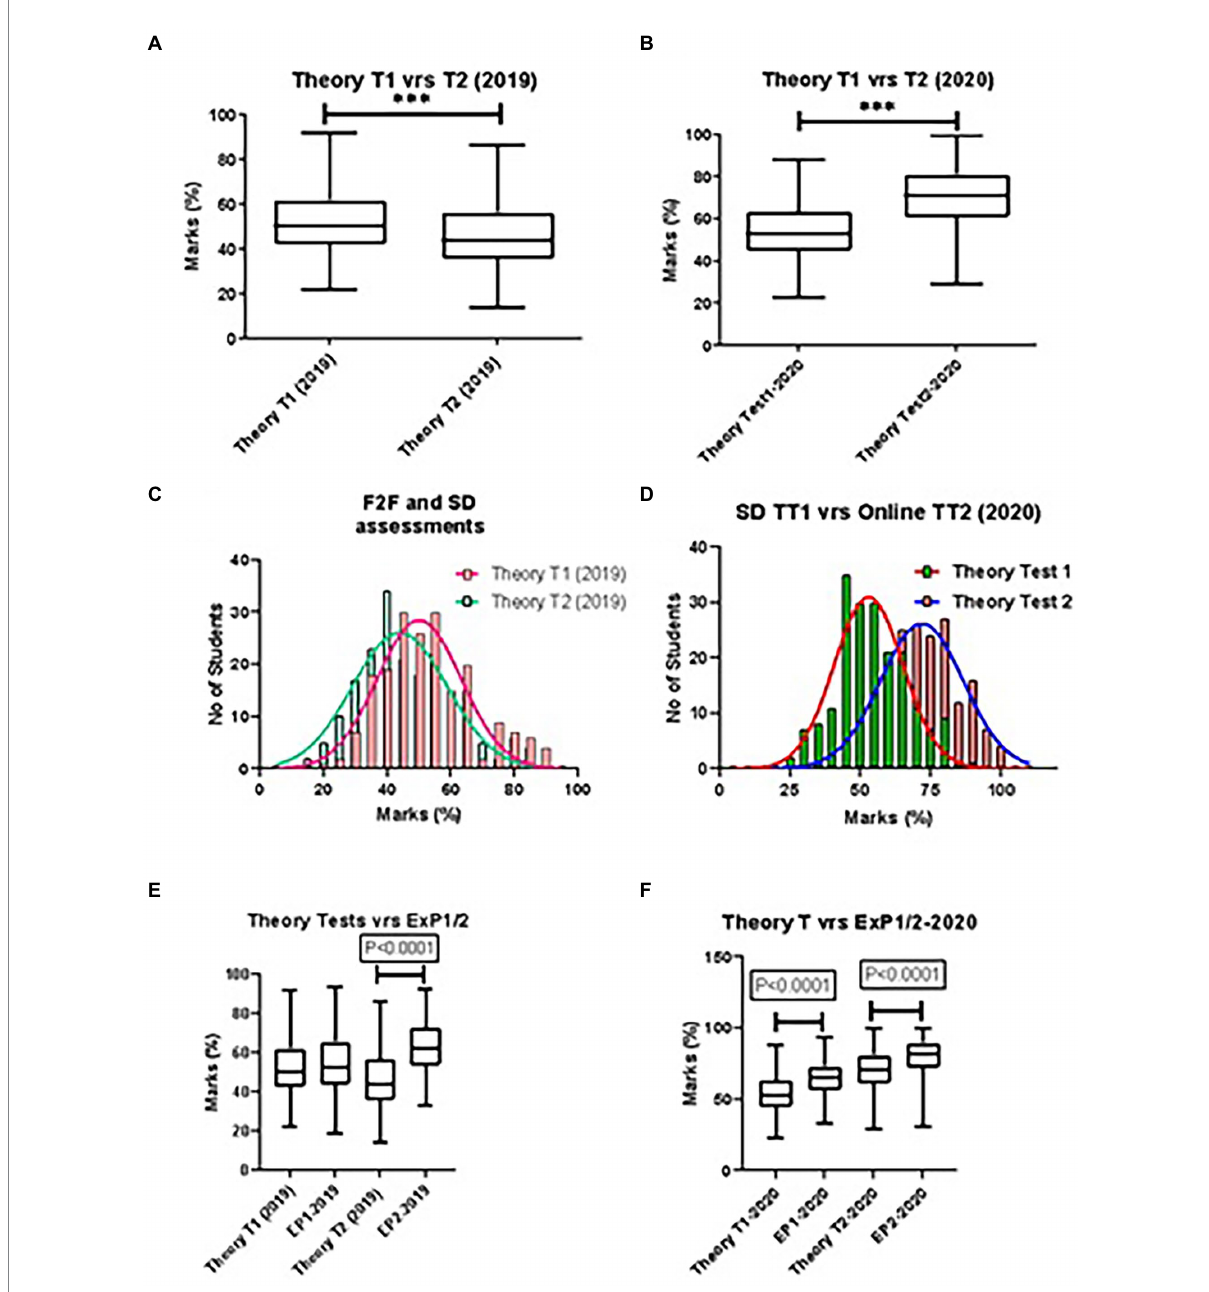
FIGURE 3 (A) The assessment data (2019) represents normal F2F lectures and orthodox sit-down (SD) assessments. Theory Test 2 had lower Quartile groups 2 and 3, including a slightly lower median; statistical analysis showed that these sets of data were statistically different from each other ( p < 0.0001). (B) Here, we compare the analogous data sets in 2020, where Theory Test 1 was an SD assessment compared to an online home-based assessment. Statistically, the online assessment had a significantly higher distribution of marks (%; p < 0.0001). (C,D) Here we show the analogous sets of data (to A and B , respectively) using Gaussian distribution curves superimposed on frequency distributions of the two sets of data. (E,F) “B and W” plots are used to statistically compare Theory Test 1 (T1) with the analogous Exam Paper 1 (EP1) and Theory Test 2 (T2) with the analogous Exam Paper 2 (EP2). In 2019, there was no significant difference between Theory Test 1 and Exam Pape; however, the distribution of exam assessment percentages was significantly higher in Exam Paper 2 (EP2) compared to Theory Test (T2). In 2020, in both comparisons, the distribution shifted to the right in exam assessment percentages was significantly higher than in the term